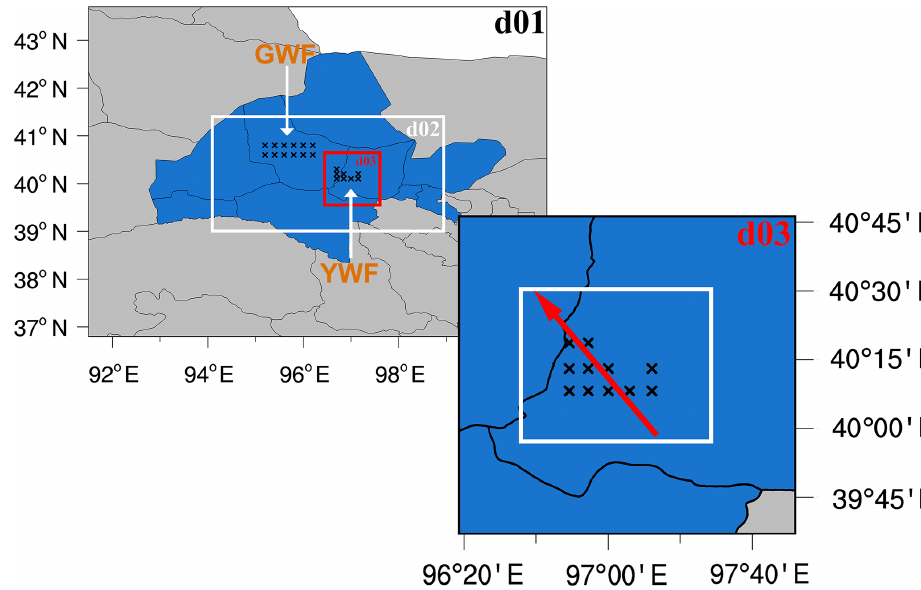
Figure 2. Nested model domains, including large domain d01 (upper-left panel), the medium size domain (d02, marked by a white box) covering Guangzhou and Yumen wind farms, and the fine domain d03 marked by the red box in upper-left panel covering Yumen wind farm only. The blue shaded area is Jiuquan City. In the d01 domain, the GWF and YWF are also indicated. These two wind farms are marked by the black cross. The lower-right panel shows the enlarged d03 area. The red arrow line indicates the transect along which the concentrations cross sections are generated (see Sect. 3). The white box represents the d03 domain covering YWF and its surrounding